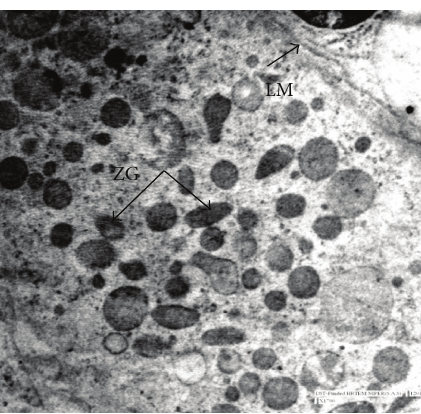
Figure 8: Electron micrograph at 32 cm CVRL (146 days) showing different shapes of zymogen granules (ZG) and lamellar membrane (LM) × 1700.